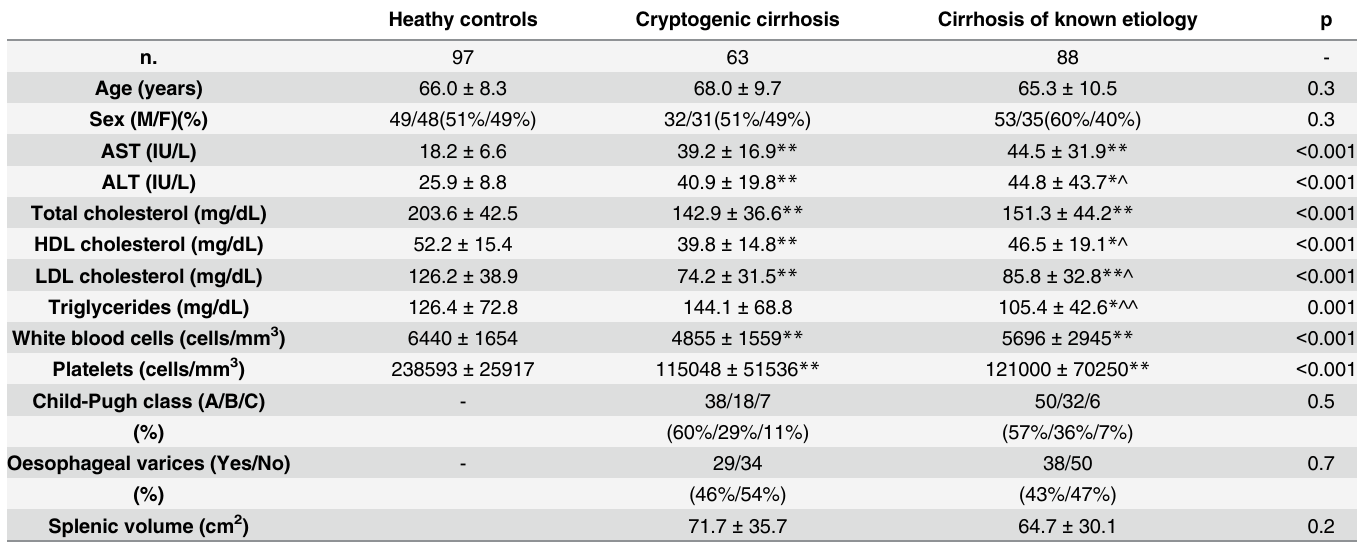
Table 1. Main characteristics of the study populations, according to subgroups. Heathy controls Cryptogenic cirrhosis Cirrhosis of known etiology